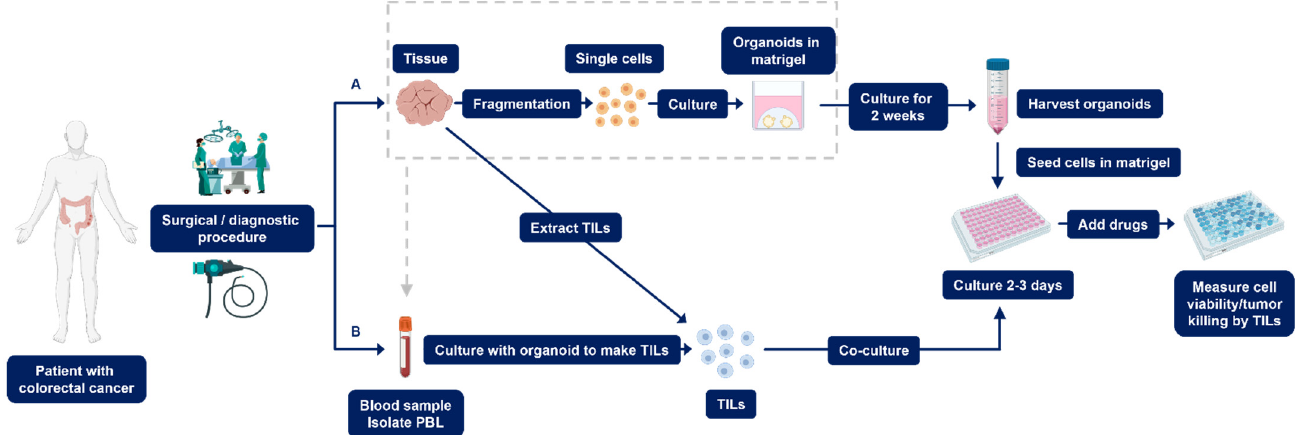
Figure 1. A flowchart depicting the drug screening methods using PDOs ( A ) and co-culture PDOs ( B ). ( A ) The tissue is obtained by either surgical or diagnostic procedures and fragmented to obtain single cells. These cells are cultured in an extracellular matrix for two weeks. Subsequently, the organoids are harvested and seeded in tissue culture plates and allowed to recover for 2–3 days. Next, drugs are added to the organoids and cell viability is measured. ( B ) The TILs are either obtained from PBLs after co-culturing with organoids or extracted from the tissue. They are then co-cultured with the organoids and subsequently exposed to the drugs. Organoid-killing by TILs is measured. PBL, peripheral blood lymphocytes; TILs, tumor-infiltrating lymphocytes; PDOs, patient-derived organoids.